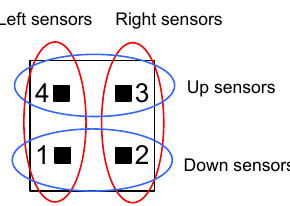
Fig. 3. Sensor’s position on the garment